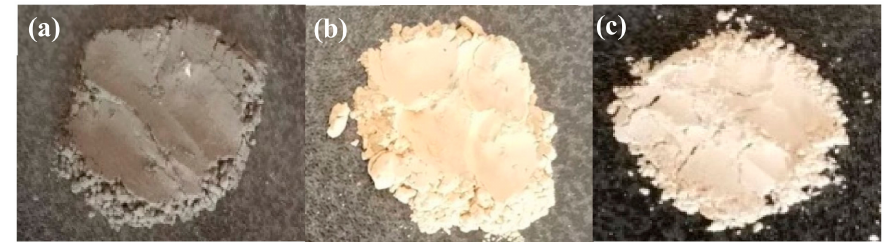
Figure 11. Whiteness pictures of ( a ) fly ash (FA), ( b ) CFA, and ( c ) ZCFA